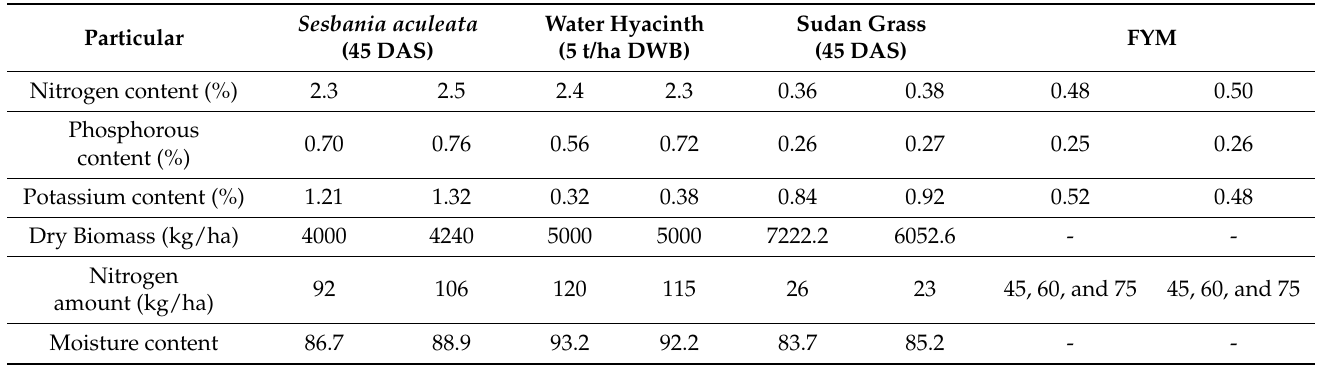
Table 1. Nutrient status of different organic materials applied in experimental